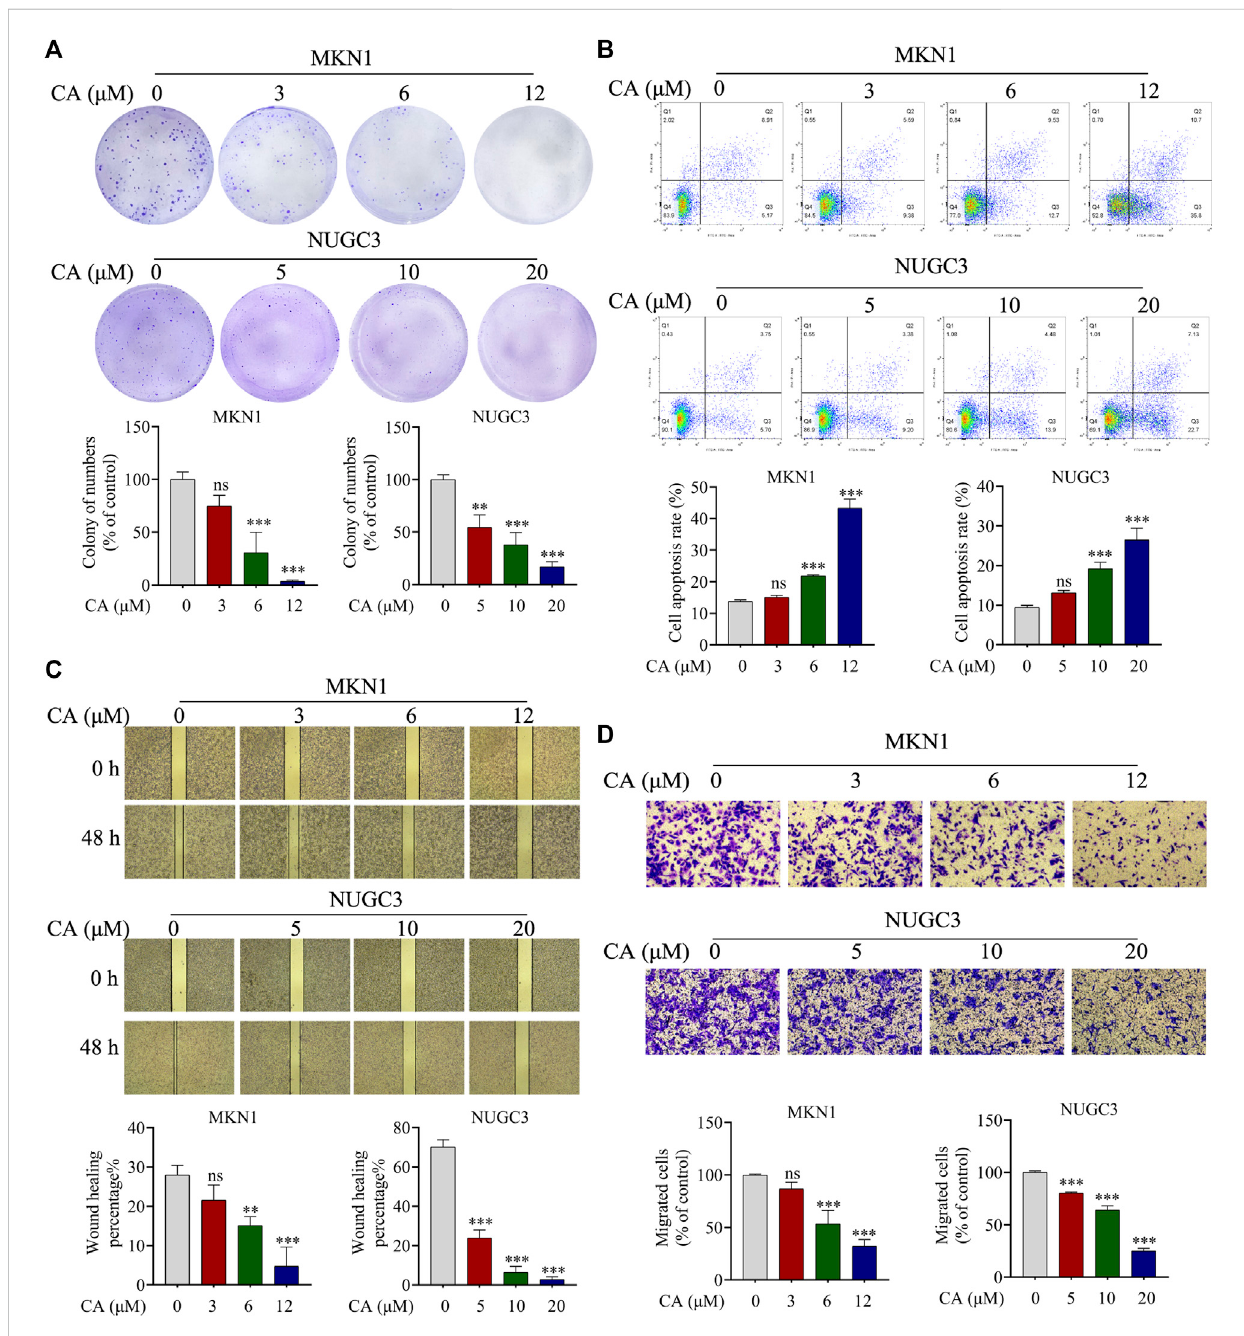
FIGURE 3 CA inhibition of biological functions in GC cells. (A) Colony formation assays for MKN1 and NUGC3 cells were performed following treatment with CA. (B) A wound healing assay was performed following CA treatment. (C) Transwell migration assays were performed following CA treatment. (D) InductionofapoptosisofMKN1andNUGC3cellsafterCAtreatment.** p < 0.01,*** p < 0.001,ns p > 0.05comparedtothecontrolgroup(n=3).One-way ANOVA test. All data are shown as the means ±